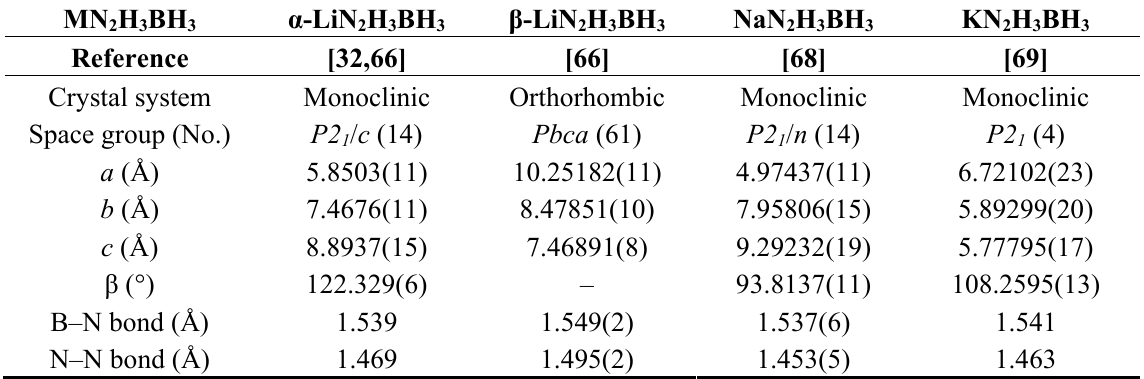
Table 2. Crystallographic data of alkali hydrazinodoboranes at room temperature (No. as number).